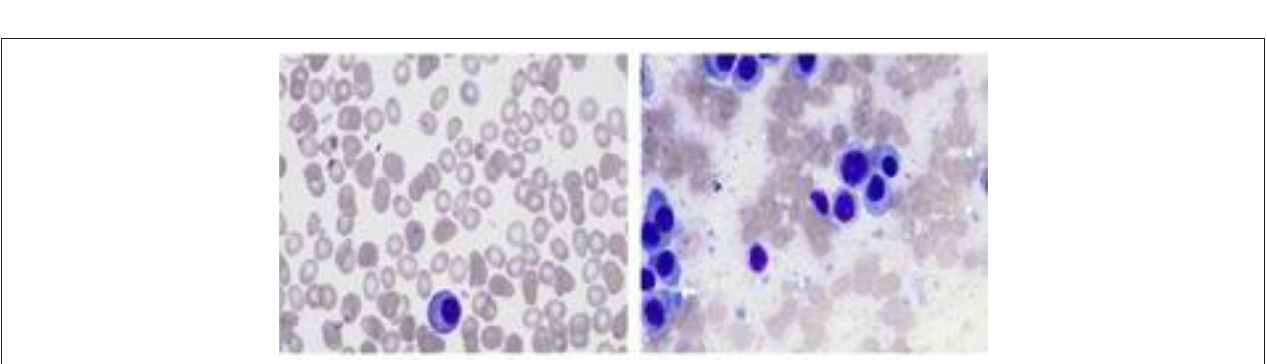
FIGURE 3 | Skull X-ray prompted that the skull and maxillofacial bone (A,B) were found to have diffuse worm-like low-density bone destruction and there was no obvious hardening at the edge. (C) Pelvis X-ray showed small and low-density bone destruction zone in the pelvis and proximal femur.